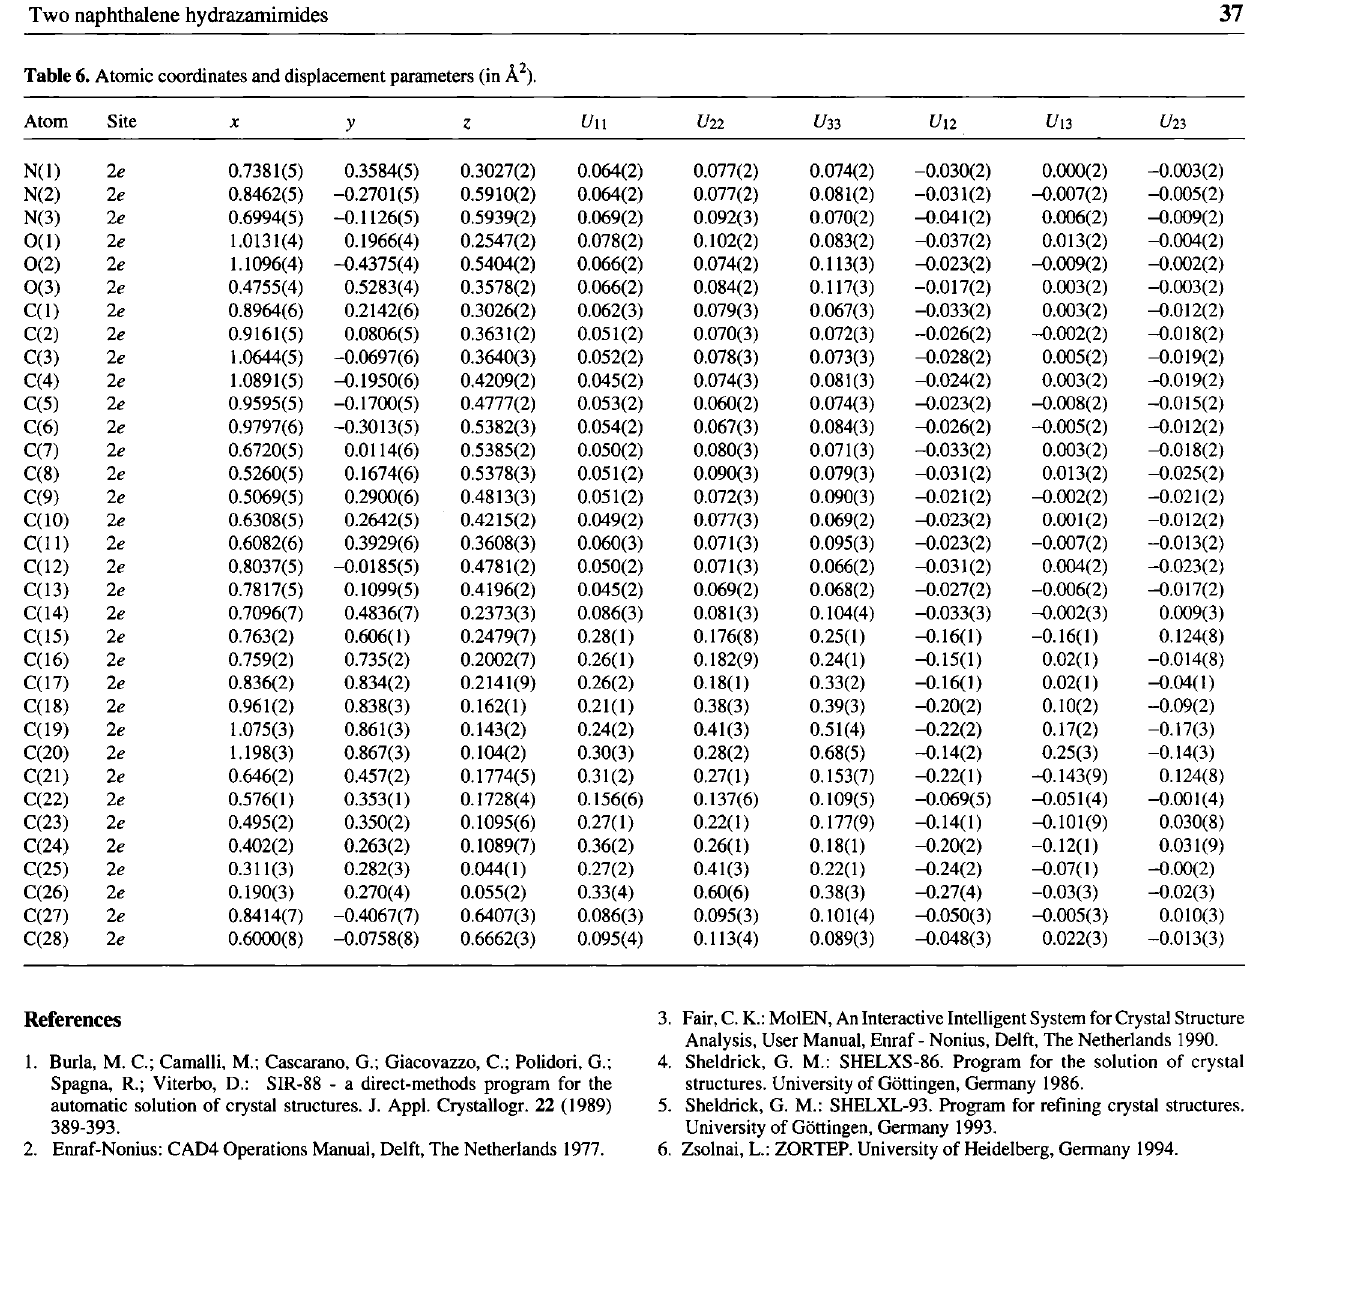
Table 6. Atomic coordinates and displacement parameters (in Â 2